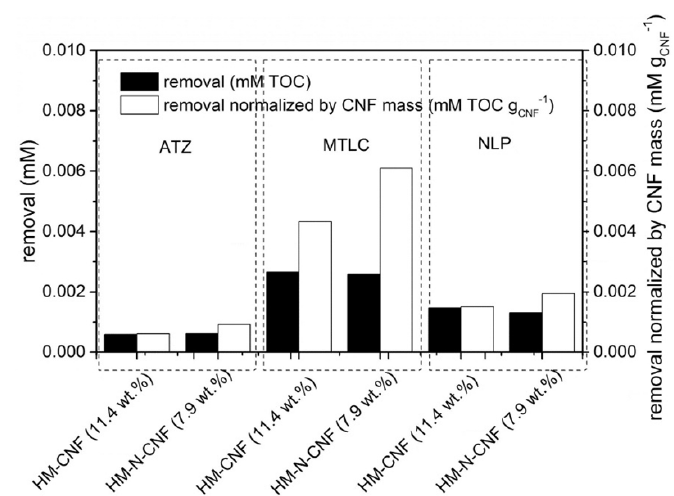
Figure 13. Removal of TOC at steady state during continuous ozonation experiments of atrazine (ATZ, C inlet = 0.046 mM), metolachlor (MTLC, C inlet = 0.070 mM), and nonylphenol (NLP, C inlet = 0.027 mM), using unmodified and N-doped CNF-covered monoliths [43].